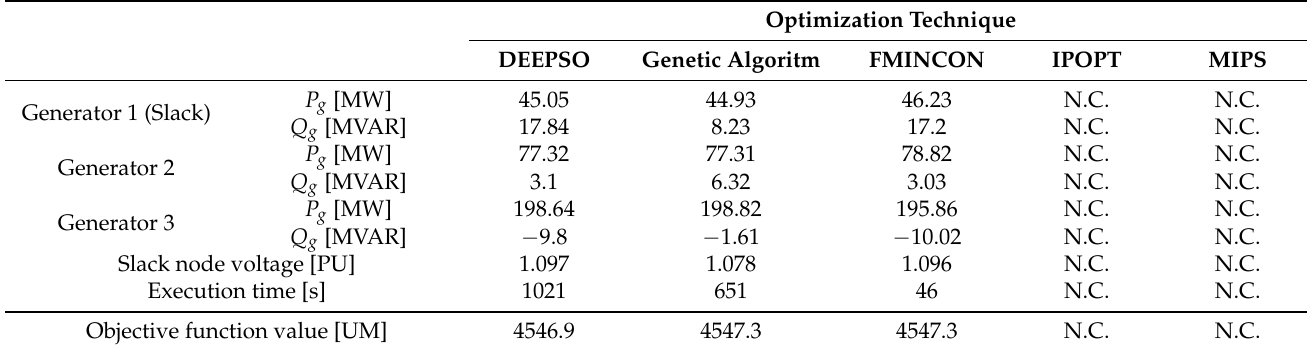
Table 5. Results obtained for the 9-node system in scenario 1.